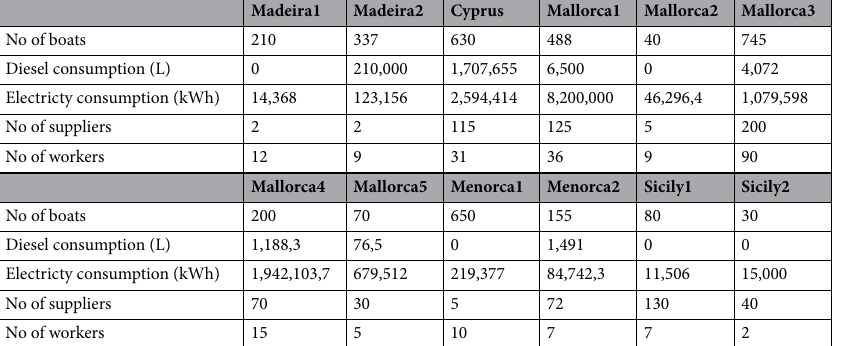
Table 3. Main characteristics of the 12 European marinas